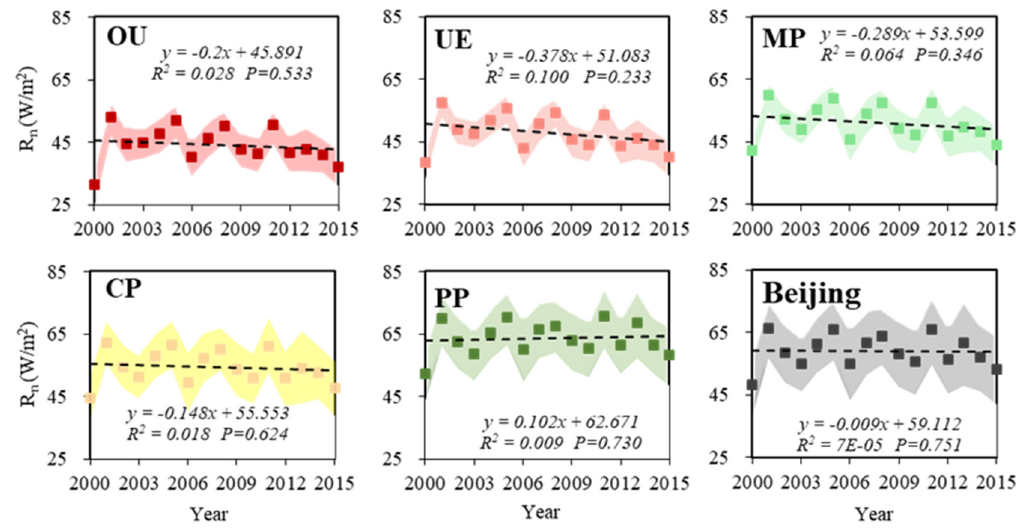
Figure 5. Variation trends of net radiation (R n ) under various land use types in Beijing from 2000 to